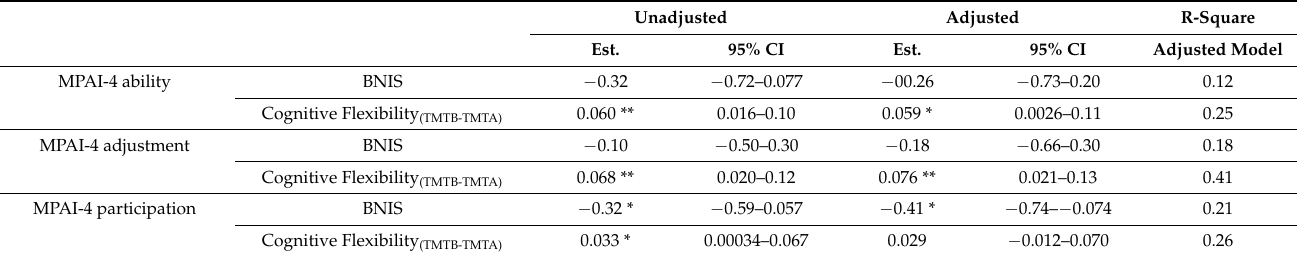
Table 4. Linear regression investigating the relationship between neuropsychological screening instruments and MPAI, adjusting for acute injury severity (including age) and educational level. Unadjusted Adjusted R-Square Est. 95% CI Est. 95% CI Adjusted Model BNIS −